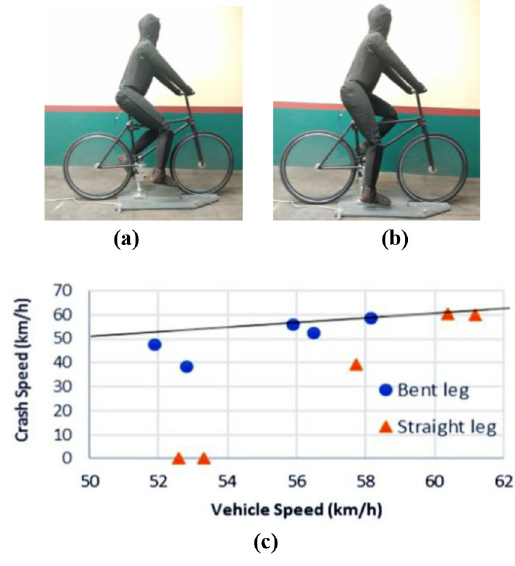
Figure 15 Comparison of bicyclist AEB system performance with different leg